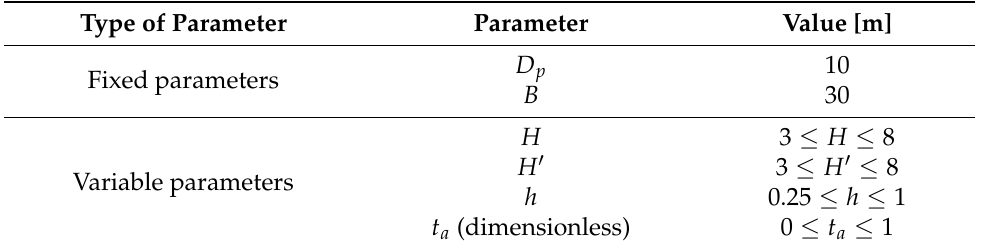
Table 4. Design parameters for the case in which the span B is